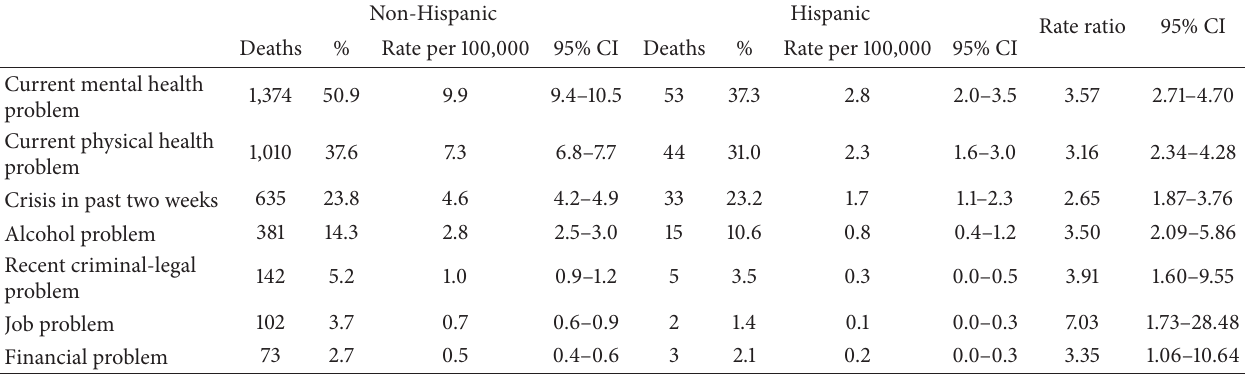
Table 3: Selected problems among drug-related deaths according to ethnicity in Utah, 2005–2010.